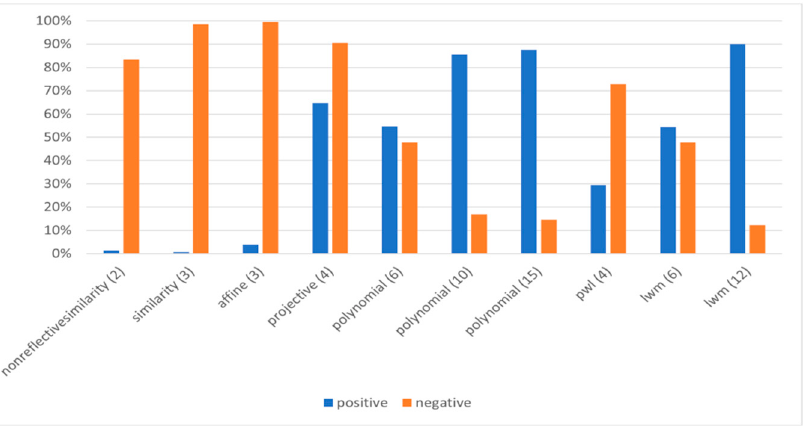
Figure 3. Share of correctly and incorrectly classified markers depending on the image transformation model used for a large search range (50 px) without removing previously classified markers from the images (the number of pairs of points necessary to determine the model parameters is given in brackets).